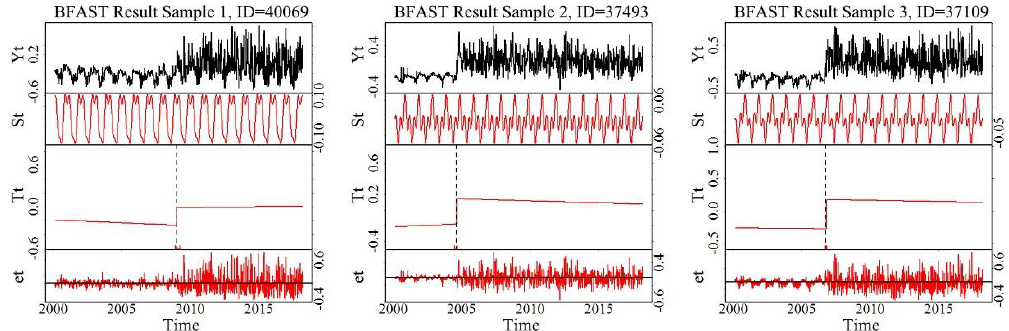
Figure 3. Plots of original NDWI time series and BFAST-decomposed seasonal, trend and remainder components and BFAST-detected break points of samples in land-to-water areas. In each plot, the four panels from the top to the bottom are original NDWI time series (“Yt”), seasonal component (“St”), trend component (“Tt”) and reminder component (“et”), respectively. The x -axis shows time. The gray vertical dashed lines in the rows of trend components indicate timing of break points within the confidence interval of 95%.